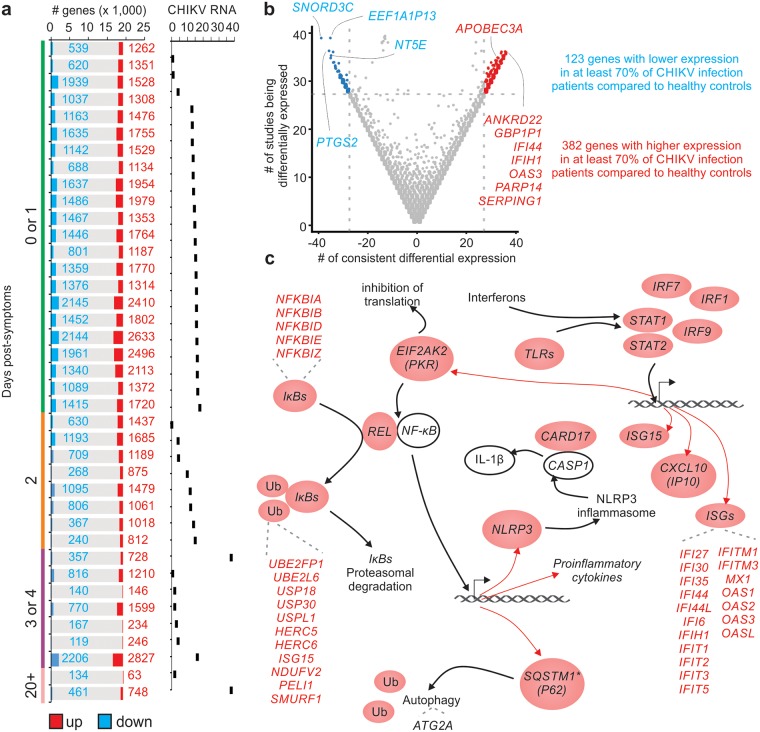
Differentially expressed genes in CHIKV patients.(a) The profile of each infected patient was compared with all of the healthy controls to indicate the number of up- and down-regulated genes. The colors represent the number of up-regulated (red) or down-regulated (blue) genes and the respective number of genes in each group. The bar graph to the right indicates the CHIKV RNA levels for each patient. (b) The meta-volcano analysis showed genes that were consistently differentially expressed (log2 fold change > 1 and adjusted p-value < 0.05) in at least 70% of the comparisons from CHIKV patients versus healthy controls. The x-axis represents the number of consistent differential expressions of each gene while the y-axis represents the number of studies in which the genes were classified as a DEG. (c) Graphical representation of the putative relationship between some of the genes that were classified as consistently up-regulated in (b).